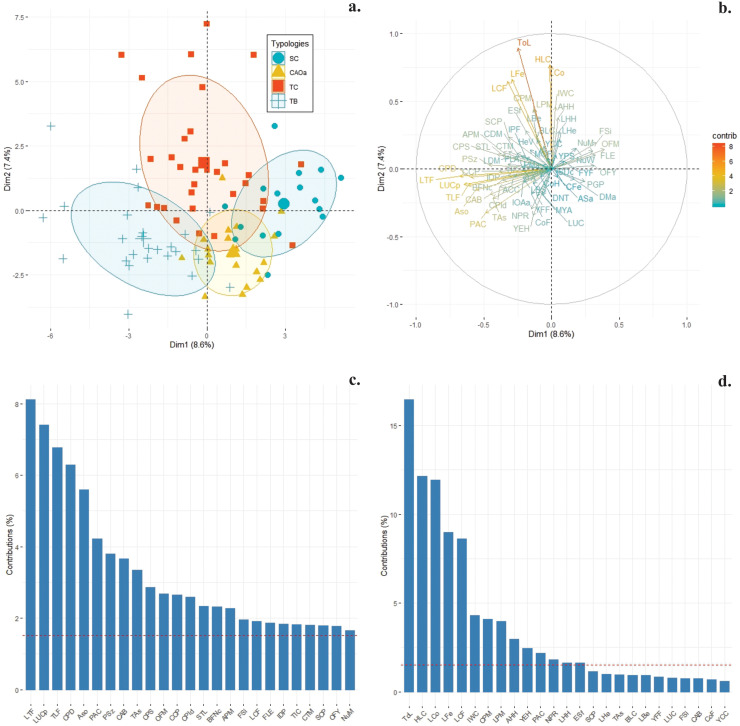
Typologies of coffee producers in southern Colombia.a. Small Conventional (SC), Conventional Associated with Organic approach (CAOa), Technified Conventional (TC), and Technified Business (TB). b. Contribution of each variable obtained through the analysis of principal components, c, and d: Variables with the greater contribution in principal component (PC) 1 and 2.